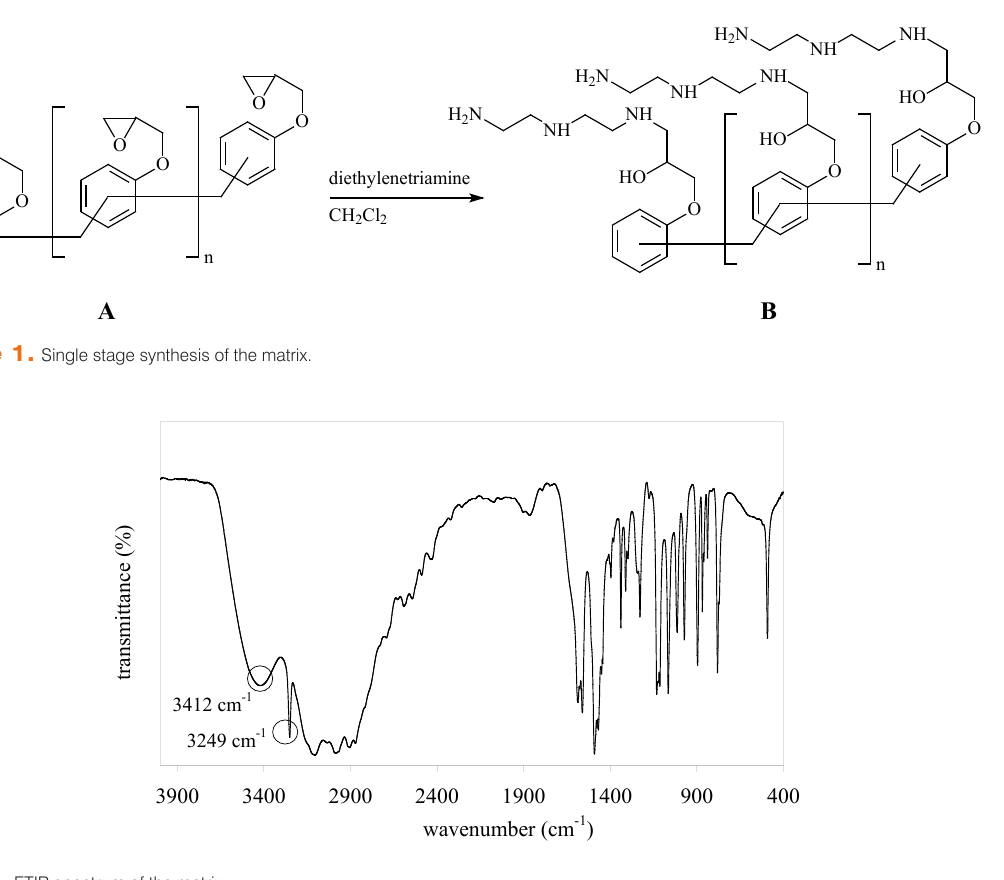
Figure 1. FTIR spectrum of the